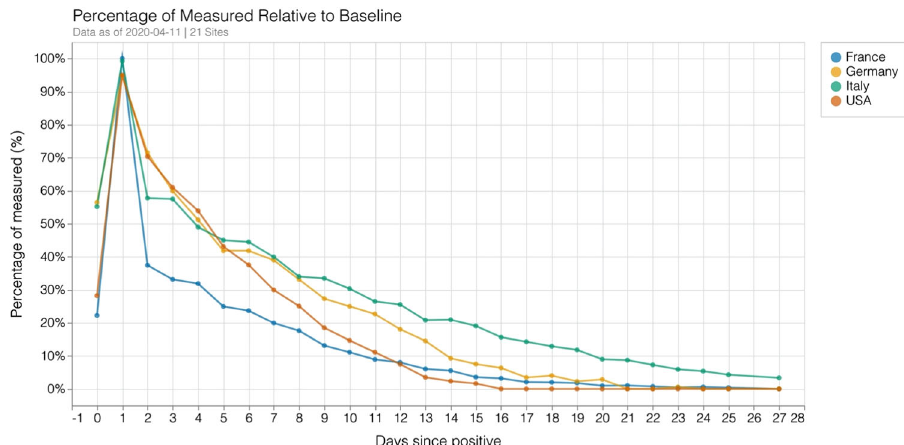
Fig. 4 Drop-off in laboratory tests reported for creatinine relative to the day with the largest number of laboratory tests reported.